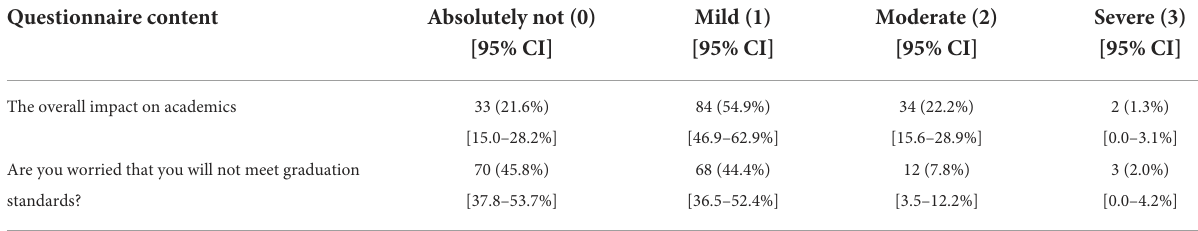
TABLE 3 The impact of the COVID-19 pandemic on medical graduate